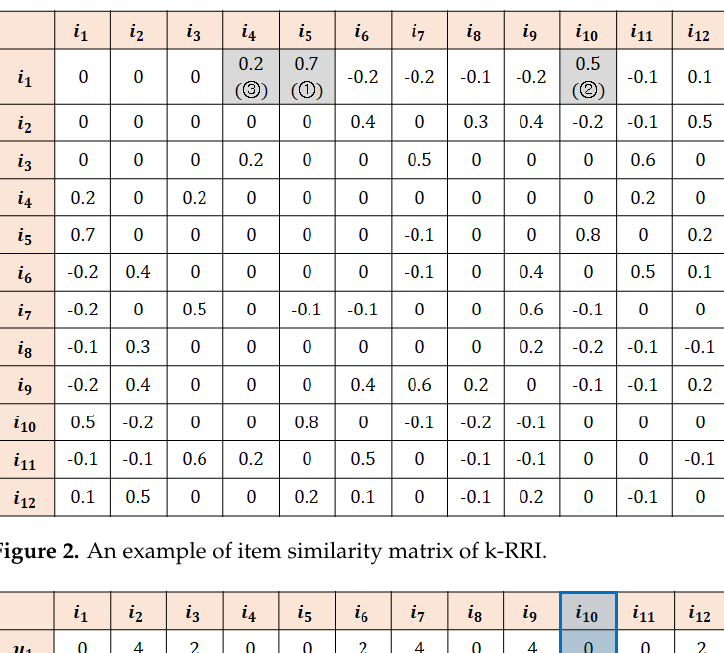
Figure 1. An example of user similarity matrix of k-RRI.